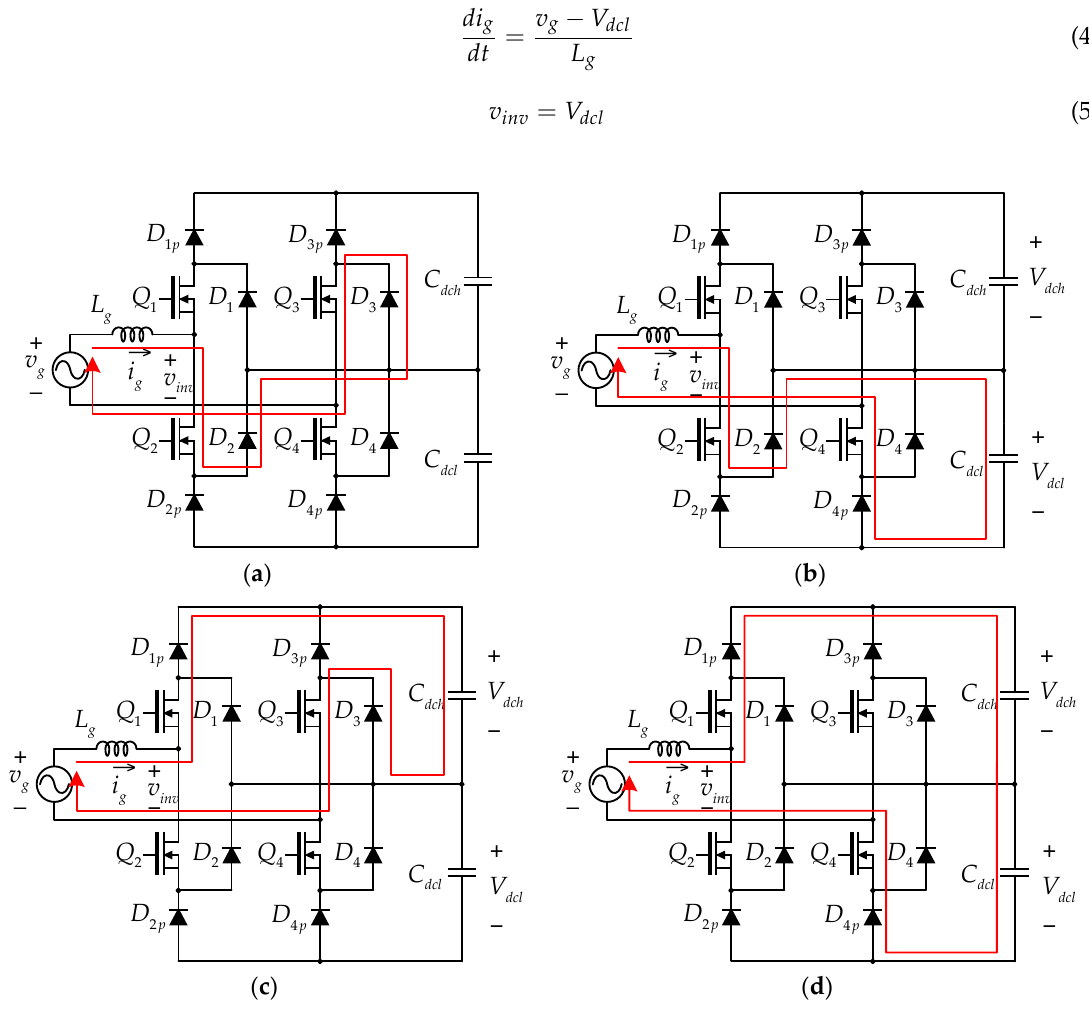
Figure 4. Operation modes of the three-level PFC converter under i g > 0. ( a ) Q = (1,1,1,1); ( b ) Q = (1,1,0,1); ( c ) Q = (1,0,1,1); ( d ) Q = (1,0,0,1).